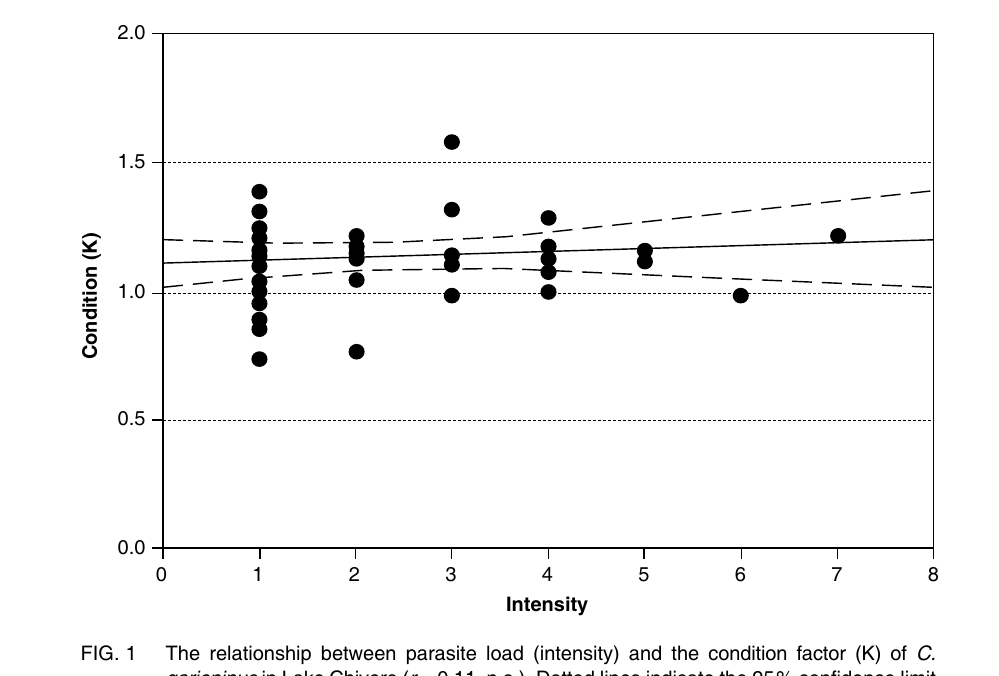
FIG. 1 The relationship between parasite load (intensity) and the condition factor (K) of C. gariepinus in Lake Chivero ( r = 0.11, n.s.). Dotted lines indicate the 95% confidence limit